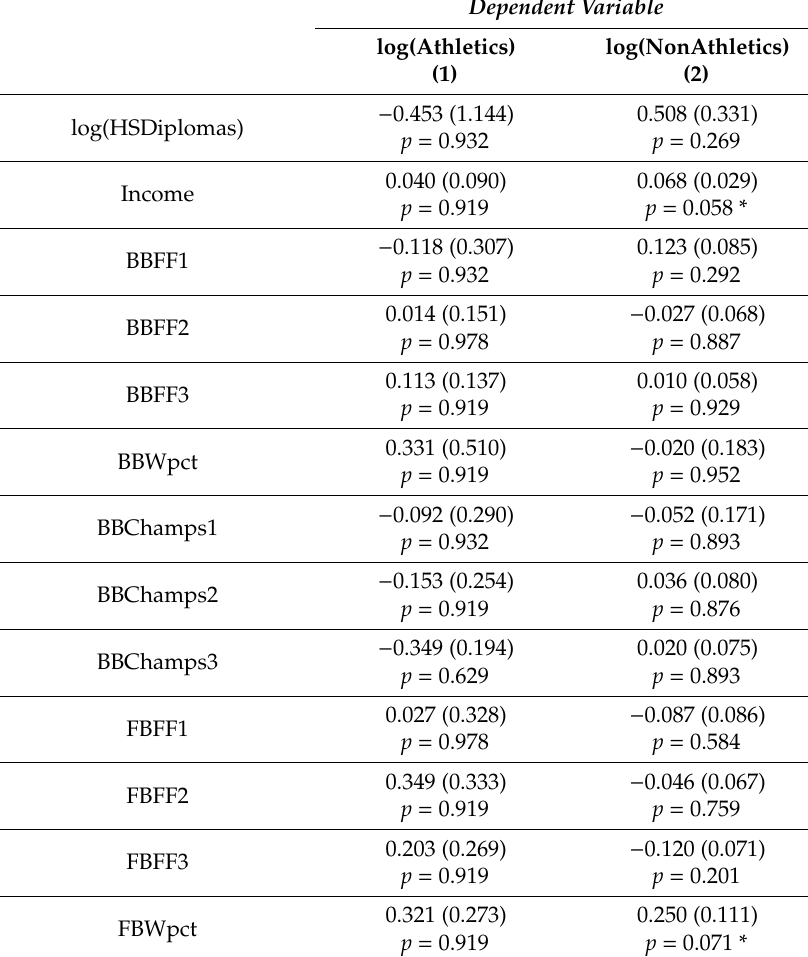
Table 5. Models for